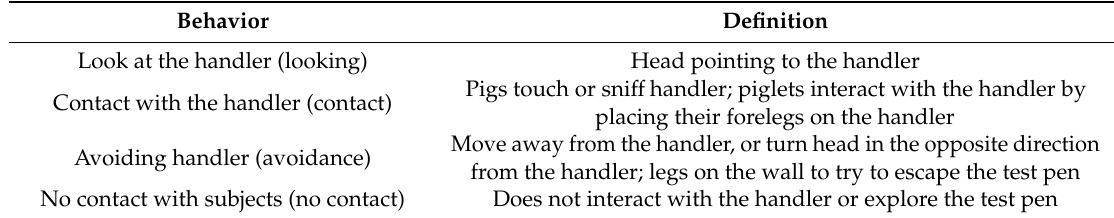
Table 2. Parameters of behavioral responses of a pig to the handler